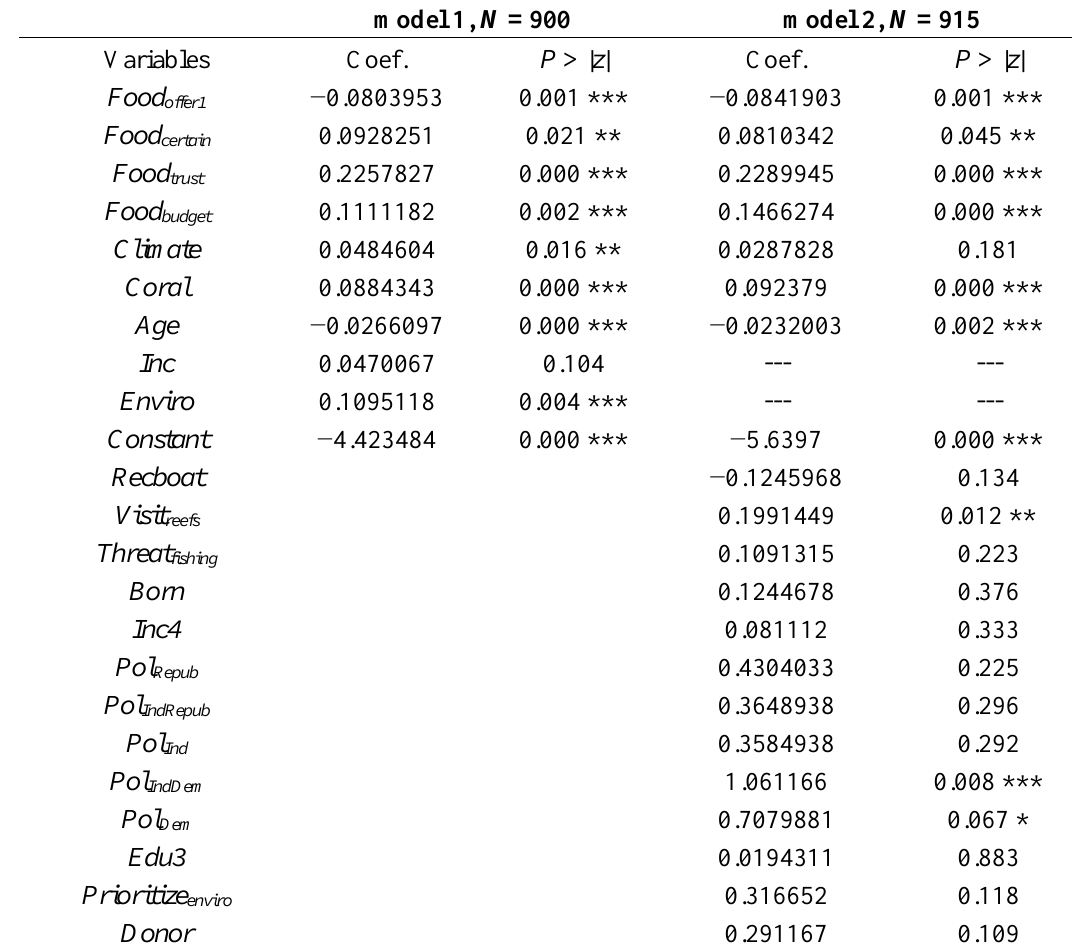
Table 4. Logit models for sustainable seafood